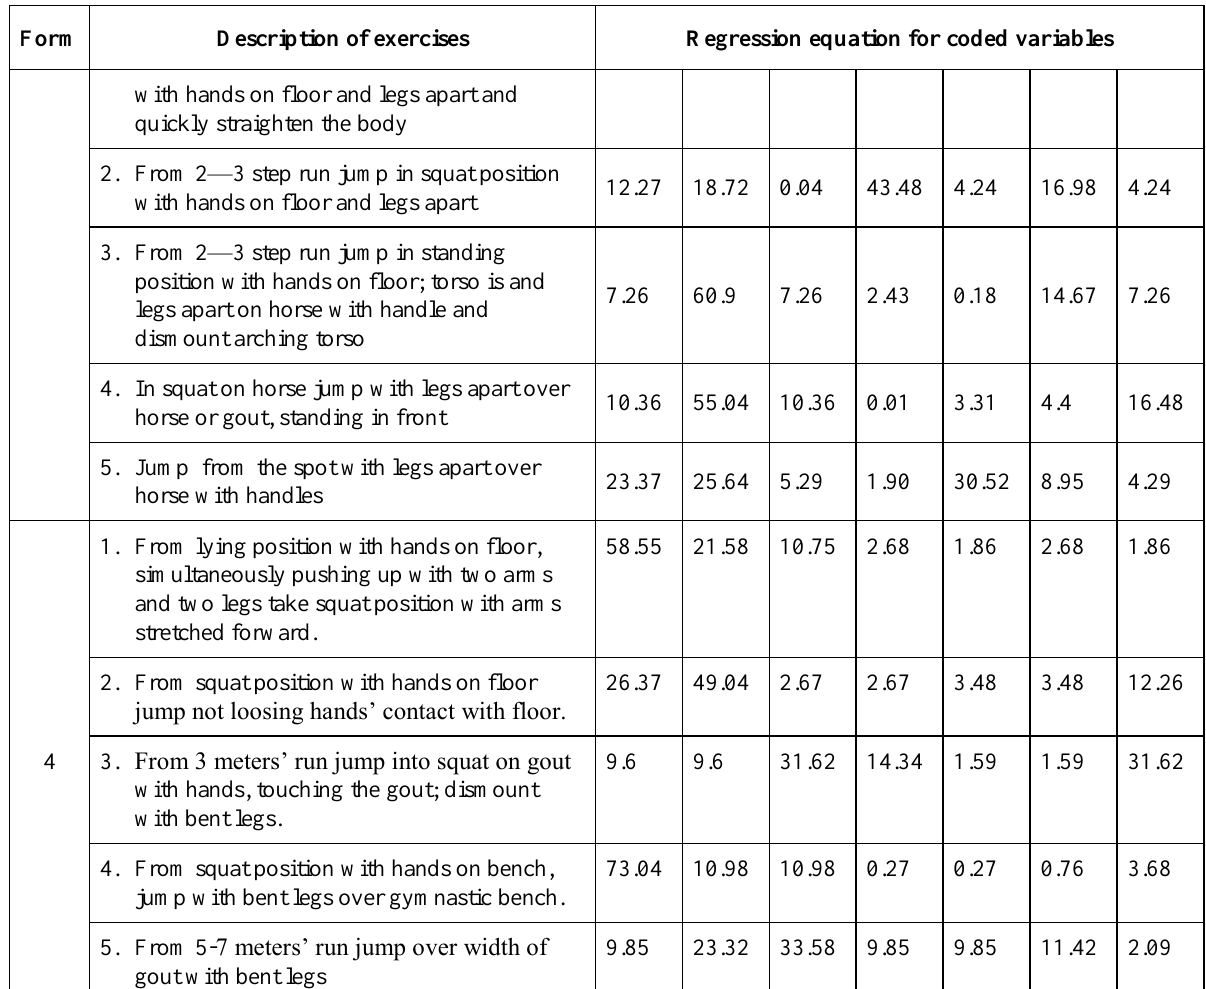
Description of exercises Regression equation for coded